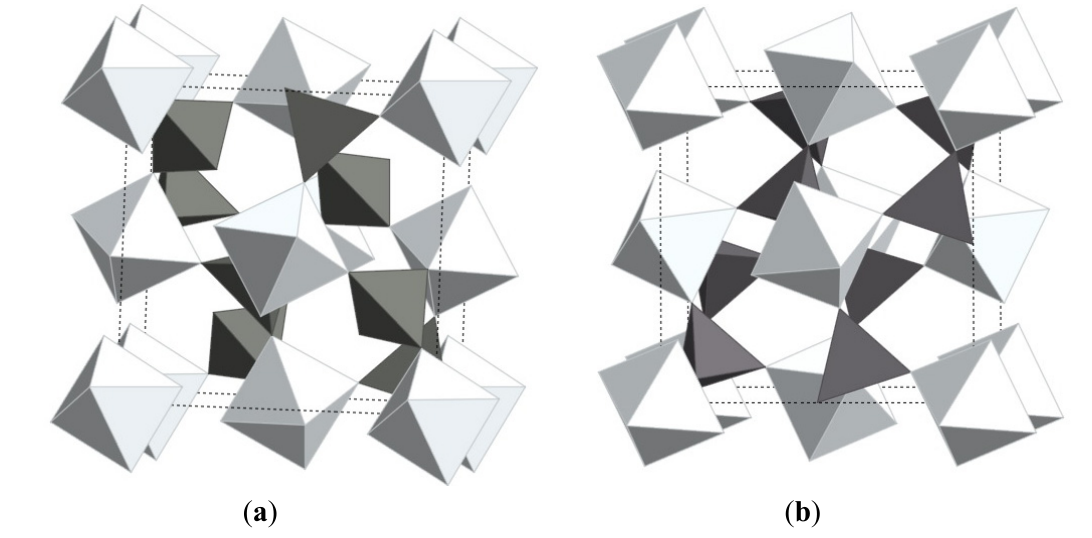
O ; ( b ) ZrV O (ideal high temperature 2 8 2 7 /VO tetrahedra. The structures only differ 4 4